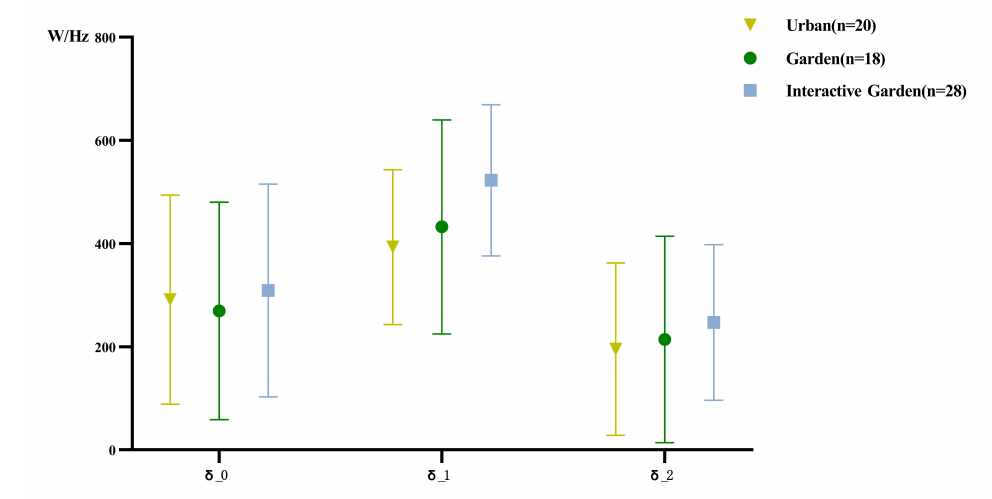
Figure 10. Descriptive statistical results 2 of PSD in different frequency